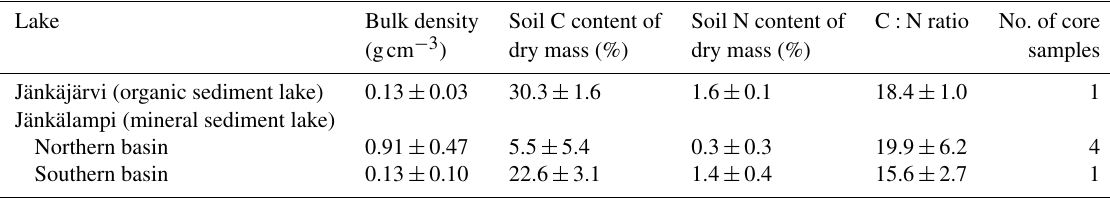
Table A8. Average bulk density, C and N content, and C : N ratio ( ± standard deviation) in the top 20cm of lake sediments. Lake Bulk density Jänkäjärvi (organic sediment lake) Jänkälampi (mineral sediment